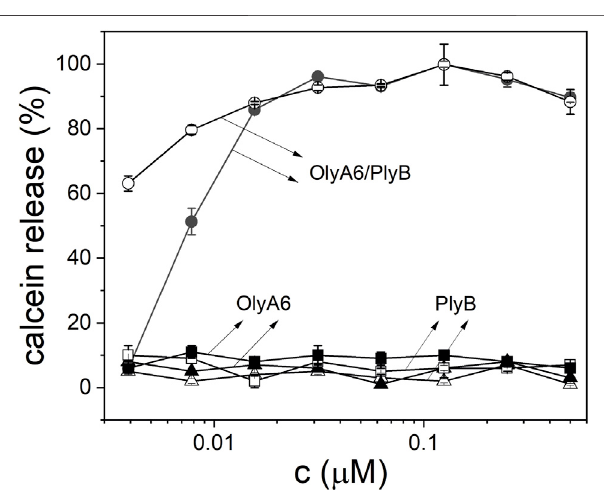
FIGURE5| Concentrationdependenceofpermeabilizationofequimolar CAEP/POPC/Chol (full symbols) and CPE/POPC/Chol (open symbols) small unilamellarvesiclesbyOlyA6/PlyB.OlyA6/PlyB molarratio=12.5/1.Individual proteins, OlyA6 and PlyB, were also tested as controls. CPE-ceramide phosphoethanolamine, Chol-cholesterol, POPC-1-palmitoyl-2-oleoyl- sn - glycero-3-phosphocholine, CAEP-ceramide